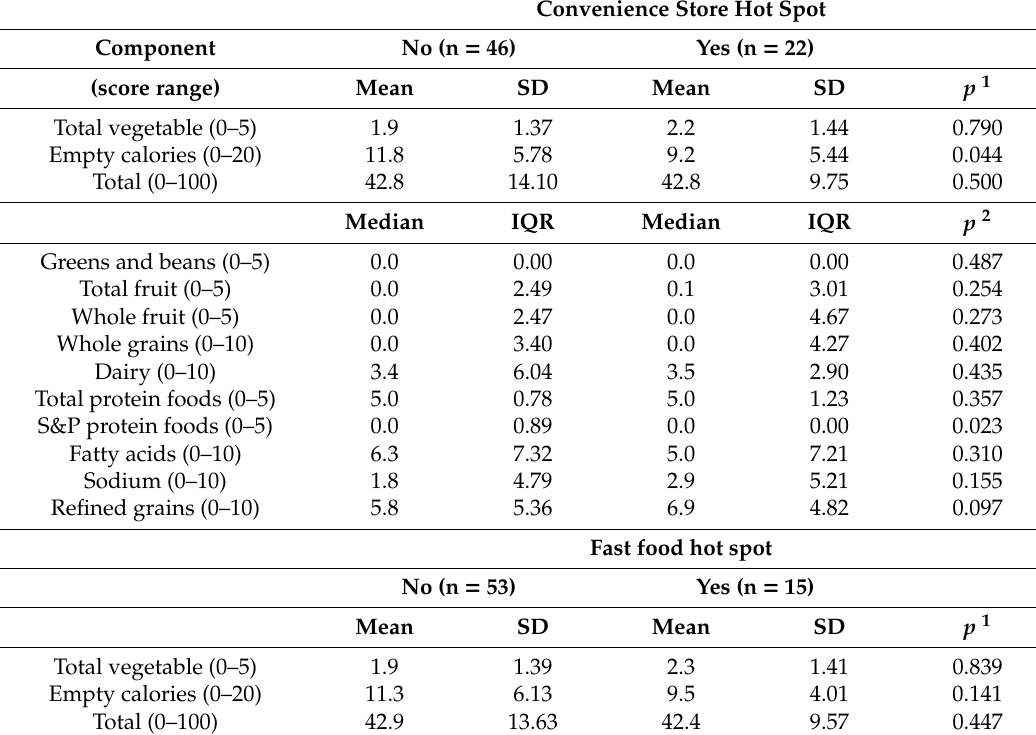
Table 4. Healthy Eating Index 2010 component and total scores by hot spot status and census tract